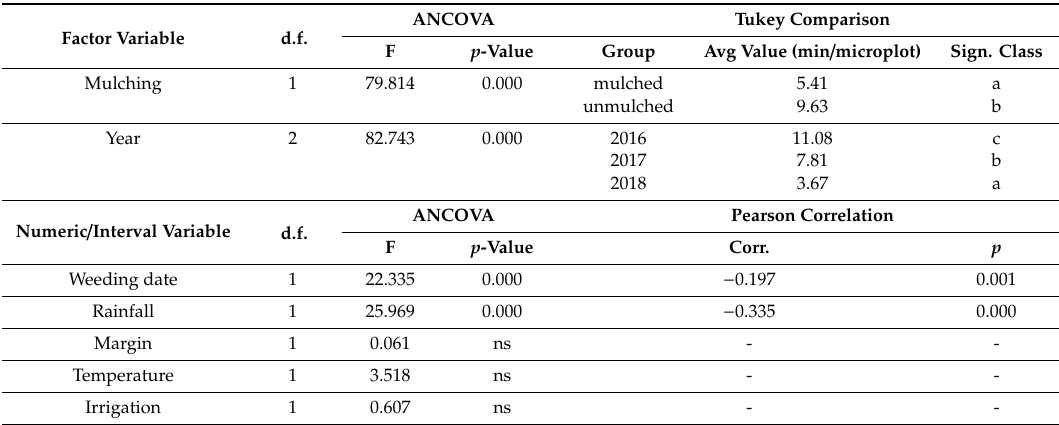
Table 3. E ff ect of explanatory variables on weeding time (min / microplot) in an open-field tomato experiment (Gödöll˝o, Hungary, 2016–2018).